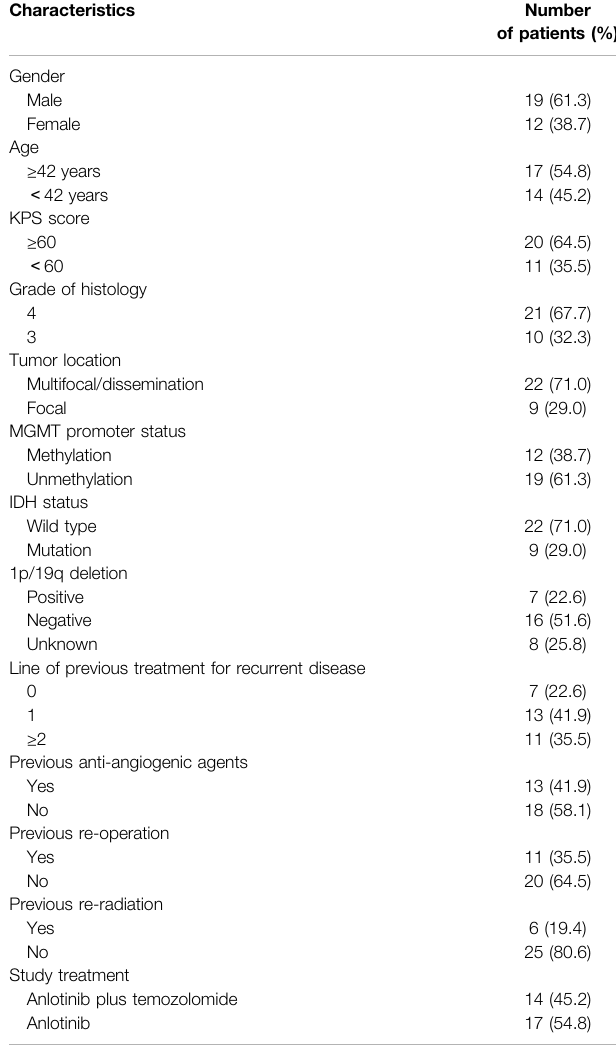
TABLE 1 | Baseline characteristics of